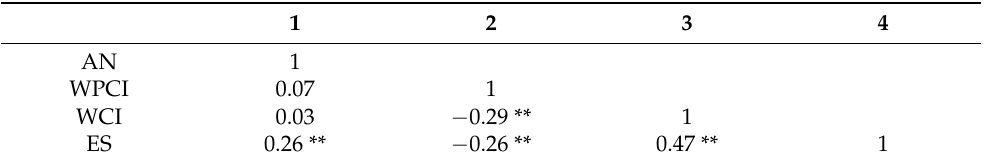
Table 2. Correlation matrix of Experiment 1. 1